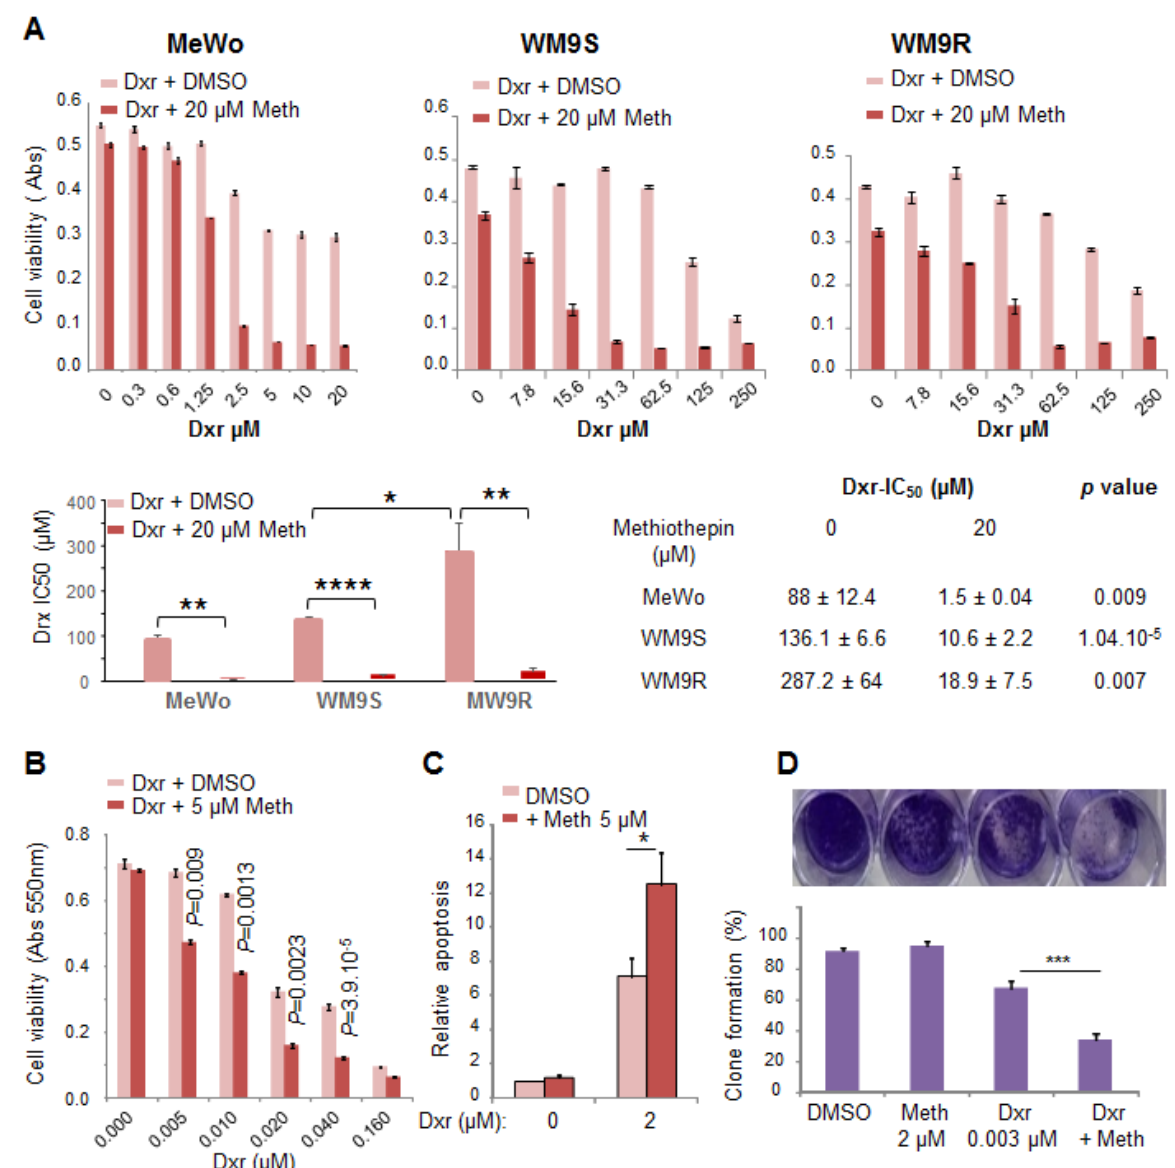
Figure 5. Methiothepin increases the sensitivity of melanoma cells to doxorubicin. ( A ) Methiothepin increases dxr cytotoxicity. Cell viability was measured after 24 h’ treatment with increasing concentrations of dxr with or without methiothepin (Meth) on MeWo, WM9S, and WM9R melanoma cells, and IC 50 of dxr were calculated. Mean ± SEM of drx-IC 50 from at least 3 experiments are reported in the histogram and table. Statistical differences between IC 50 without and with methiothepin were calculated using the student’s t-test. Significance was attained at p < 0.05 (*) (**: p < 0.005, ****: p < 0.00005). ( B ) Methiothepin increases dxr anti-proliferative effect. Cell viability was measured after seven days’ treatment with increasing concentrations of dxr with or without methiothepin on MeWo melanoma cells. ( C ) Methiothepin increases dxr pro-apoptotic effect. MeWo cells apoptosis was evaluated using the luminescent assay Caspase-Glo 3/7 after 48 h’ treatment with medium alone or with medium containing dxr alone, methiothepin alone, or dxr and methiothepin together. Histograms represent the mean ± SEM of three independent experiments and data were analyzed using ANOVA multiple comparison test and Bonferroni correction. Significance was attained at p < 0.05 (*). ( D ) Methiothepin increased the dxr anti-clonogenic effect. Cells were seeded in 24 well-plates and treated with DMSO as control, dxr alone, methiothepin alone, or dxr and methiothepin together. After 14 days, clones were revealed with crystal violet solution, pictures were taken and absorbance was read at 550 nm after solubilization. Histograms represent the mean ± SEM of at least three independent experiments and were analyzed using ANOVA multiple comparison test and Bonferroni correction. Significance was attained at p < 0.05 (*) (***: p <